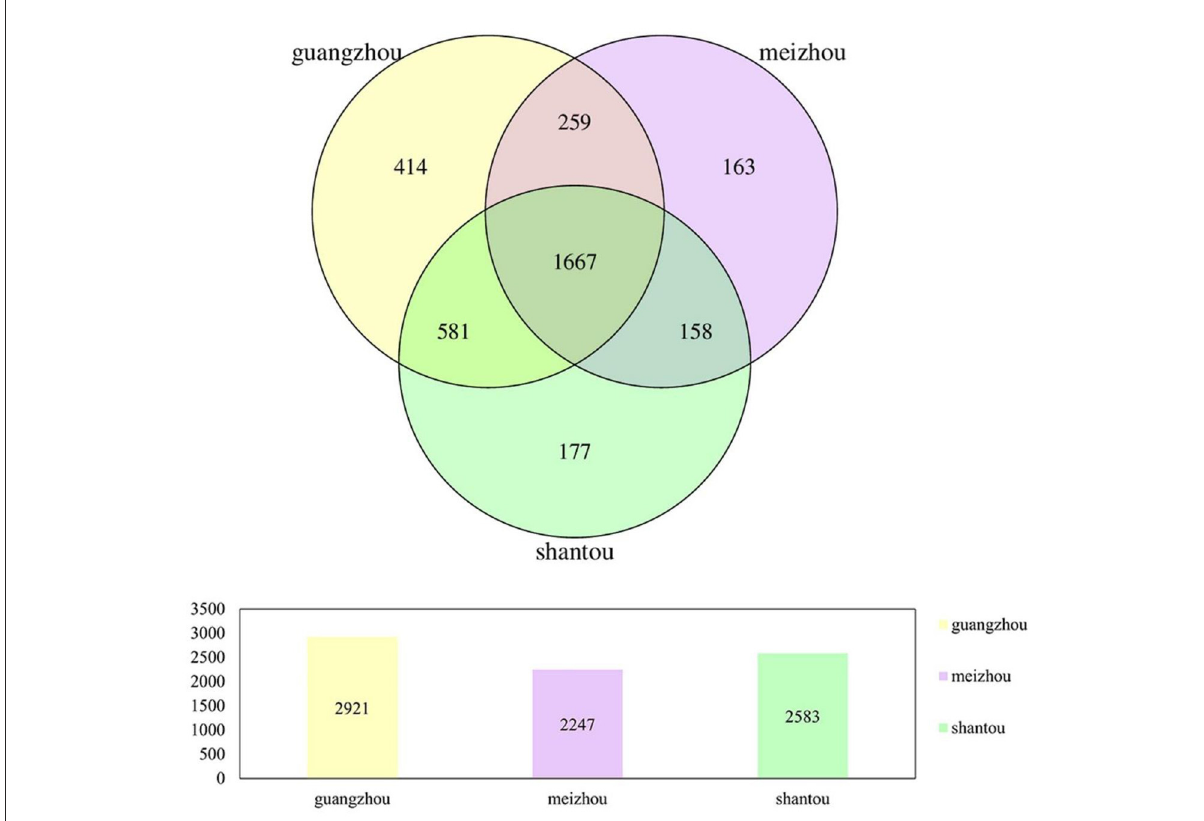
FIGURE1 Venn diagrams of bacterial OTUs in all fecal samples from people in Guangzhou, Meizhou and